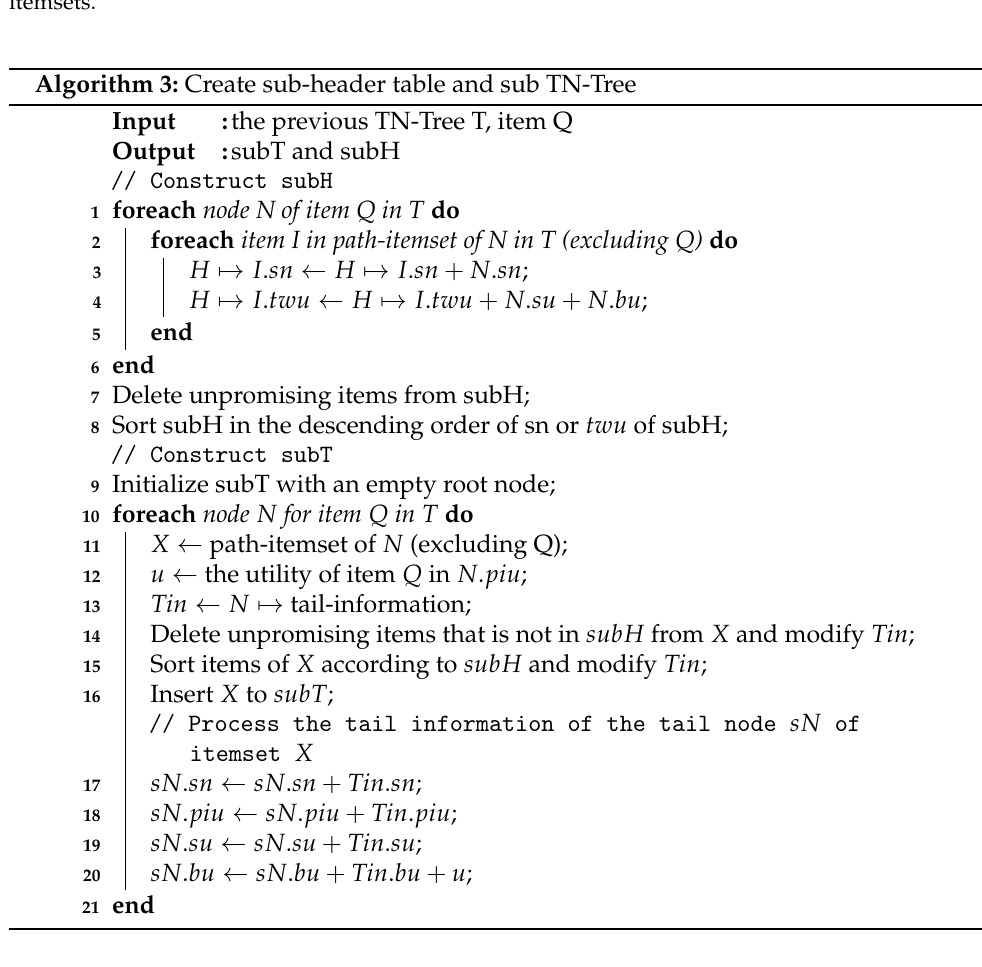
Figure 4. The tail-node tree-based high-utility itemset (TNT-HUI) algorithm for mining high utility itemsets.